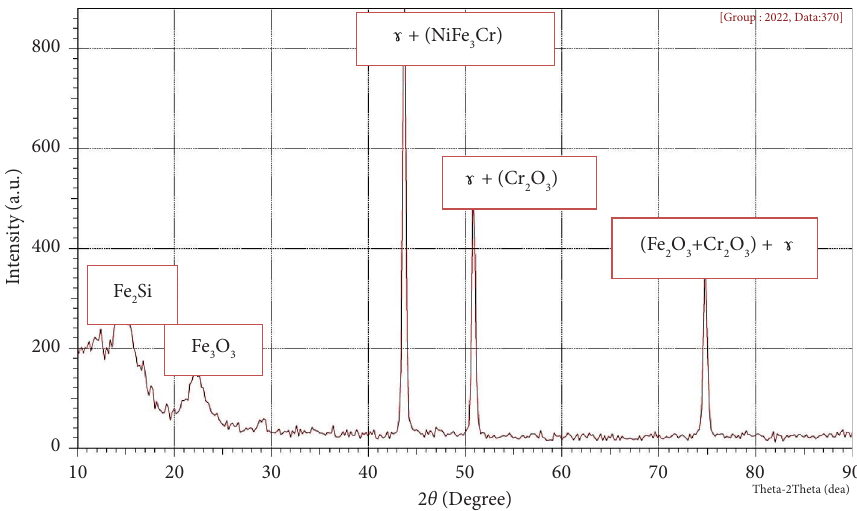
Figure 5: XRD patterns of stainless steel 316L with silicon carbide composite.